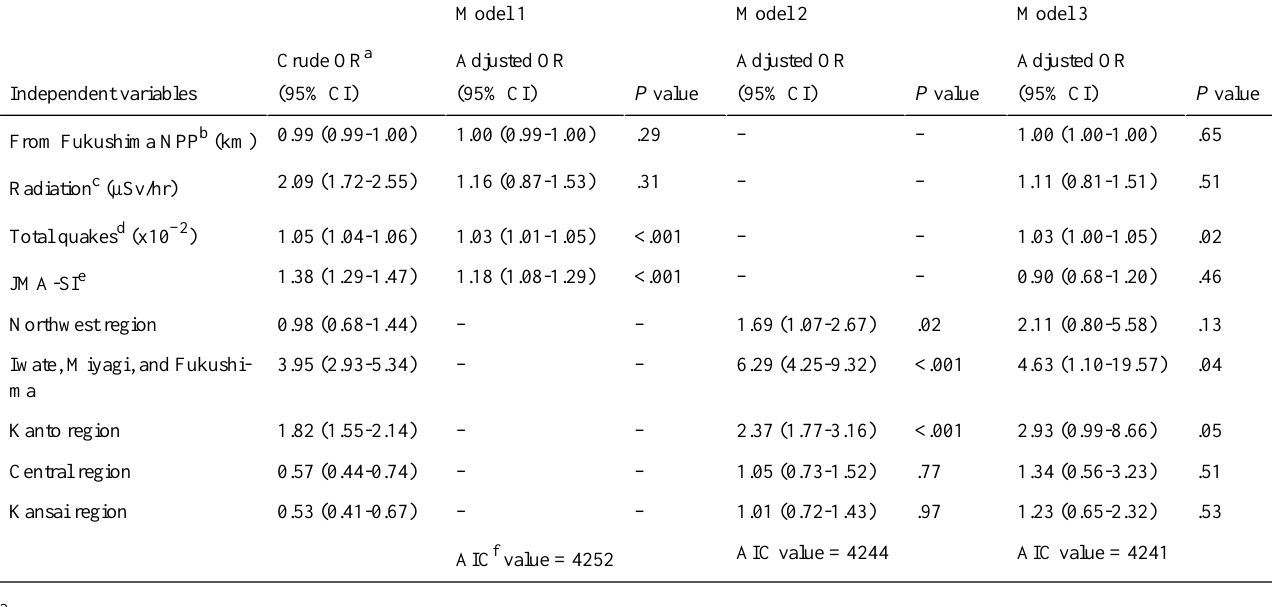
Table 3. Prefecture-level factors associated with decreased health status: regional-level logistic regression